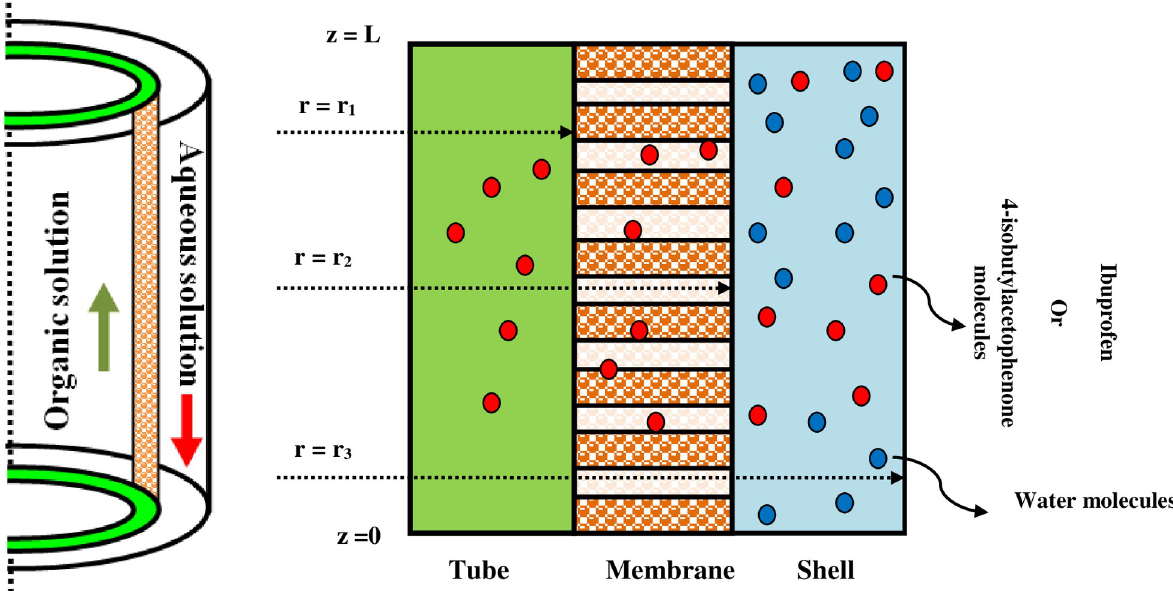
Fig 1. The schematic illustration of the IP and 4-IBAP mass transport and simplified geometry of the PMC.